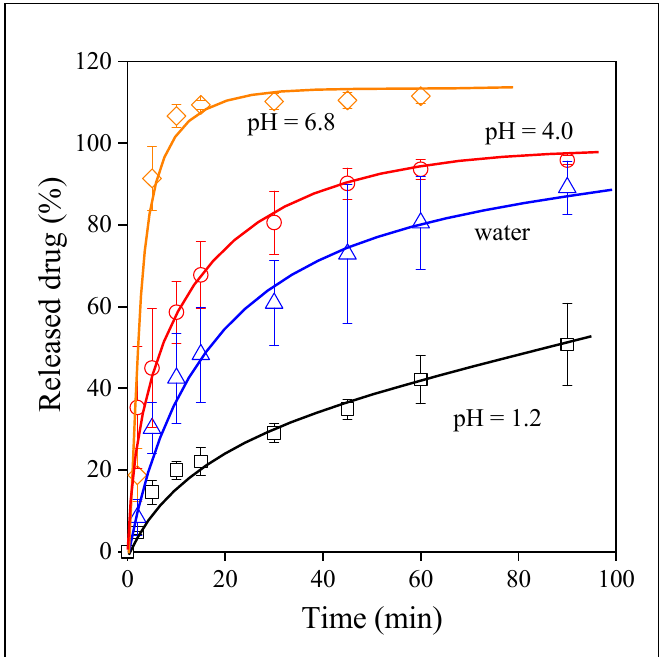
Figure 8. Release kinetics of valsartan from PVP electrospun fibers. Symbols: ( ) pH 1.2, ( ) pH 4.0, ( ) pH 6.8, ( ) water.